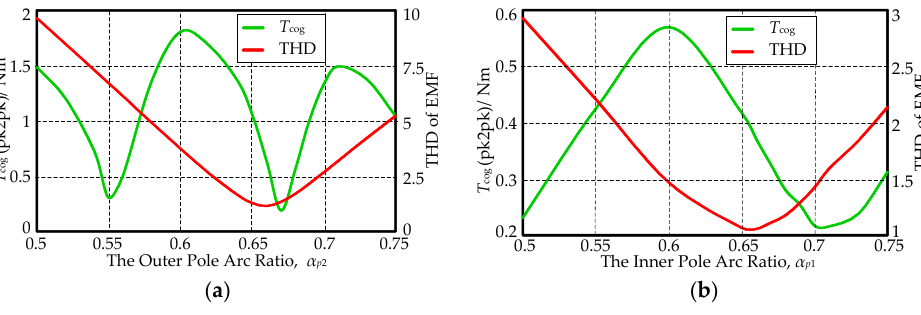
Figure 15. Cogging torque and THD as a function of the pole arc ratio: ( a ) The influence of outer pole arc ratio α p2 ; ( b ) The influence of inner pole arc ratio α p1 .